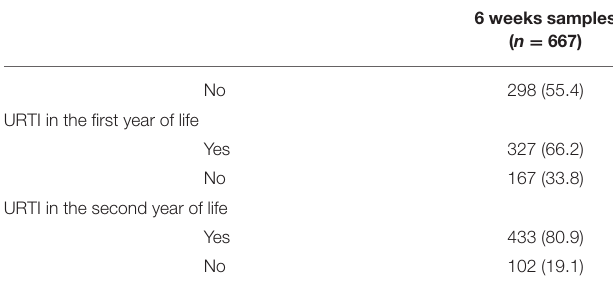
TABLE 2 | Characteristics of lactating mothers and infants who had a complete set of data on human milk oligosaccharides and atopic dermatitis available in the Ulm SPATZ Health